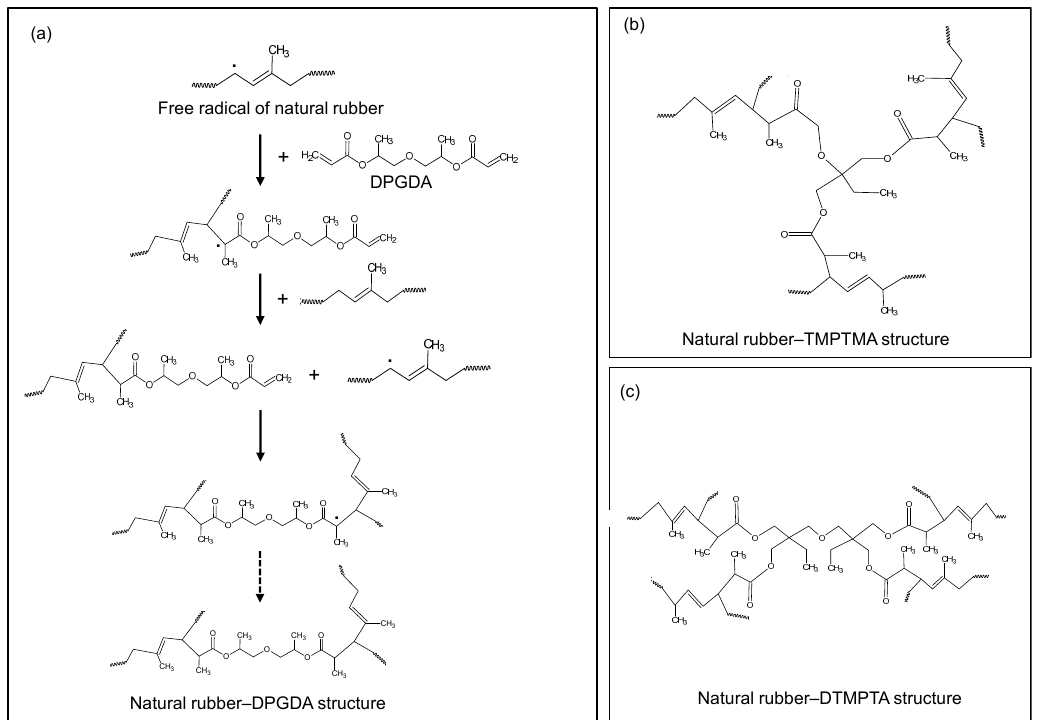
Figure 6. Formation mechanism ( a ) and network structures ( a – c ) of natural rubber formed by using coagents with different functionalities.